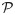
Plots of results using 4 performance measures.A: The percent of all first P that fall anywhere within the GTM for each tested algorithm and dataset. B: The percent of all first P that fall within the GTM AND within the parafovea for each tested algorithm and dataset. C: The percent of all first P that fall within the GTM AND within the parafovea AND at least 27% of the GTM (by area) lies within the parafovea for each algorithm but for only the Thorpe images. D: The percent of all first P that fall within the GTM AND within the parafovea AND at least 41% of the GTM (by area) lies within the parafovea for each algorithm but only for the Potter images.